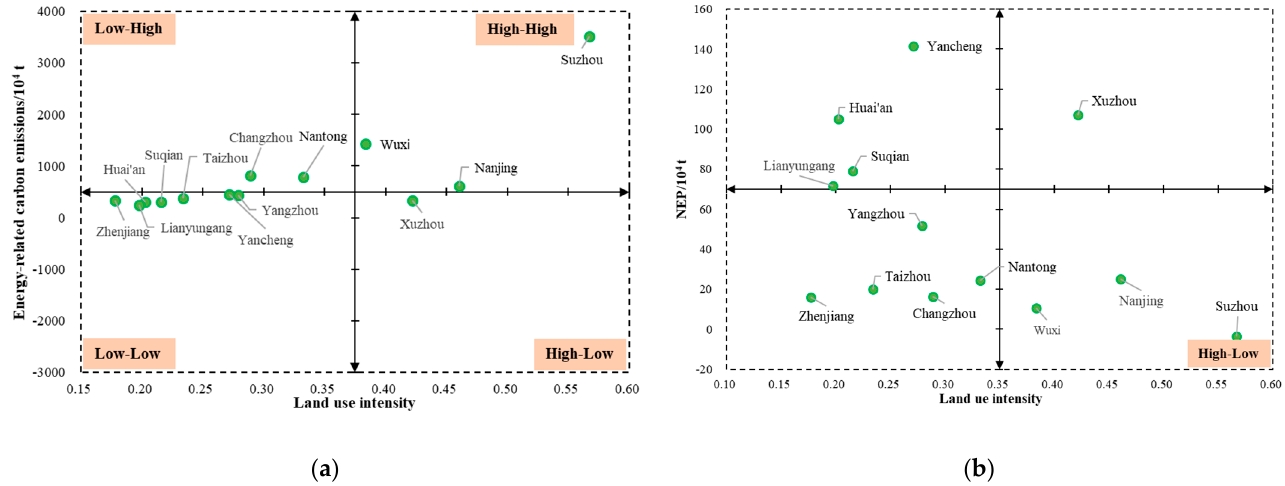
Figure 8. Classifications of 13 cities on the basis of land use intensity change and energy-related CE change ( a ), and NEP change ( b ), respectively .